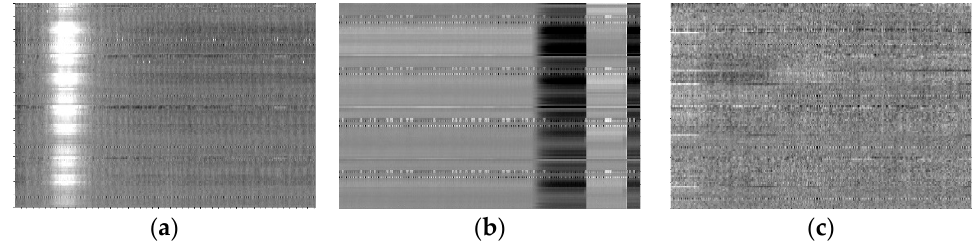
Figure 1. Solar radio spectrum data types. ( a ) Radio burst; ( b ) calibration; ( c ) non-burst.